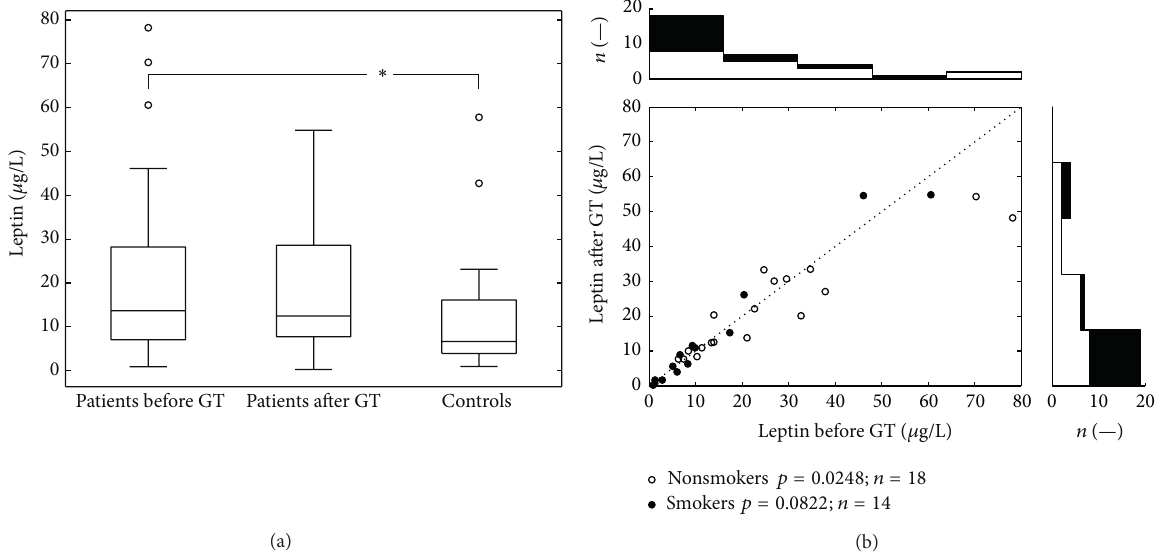
Figure 2: The variation in leptin values. (a) depicts intergroup comparisons of serum levels of leptin using Wilcoxon rank sum test (patients before and after GT versus controls). Patients before GT had significantly higher level of the leptin than controls ( 𝑝 < 0.05 ). (b) (scatter plot) depicts serum leptin levels before and after GT in patients. Pairwise comparison (Wilcoxon signed rank test) did not show any statistically significant difference. For smokers (black dots) and nonsmokers (open circles) statistics see the plot legend. All together 32 dots represent 64 measurements; each dot belongs to one patient. The top histogram shows data distribution before the treatment; the right side histogram corresponds to the posttreatment values